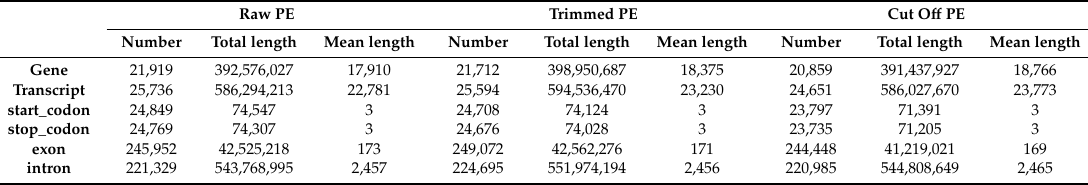
Table 7. BRAKER gene prediction results for the PLATANUS-assembled genomes. Raw PE Trimmed